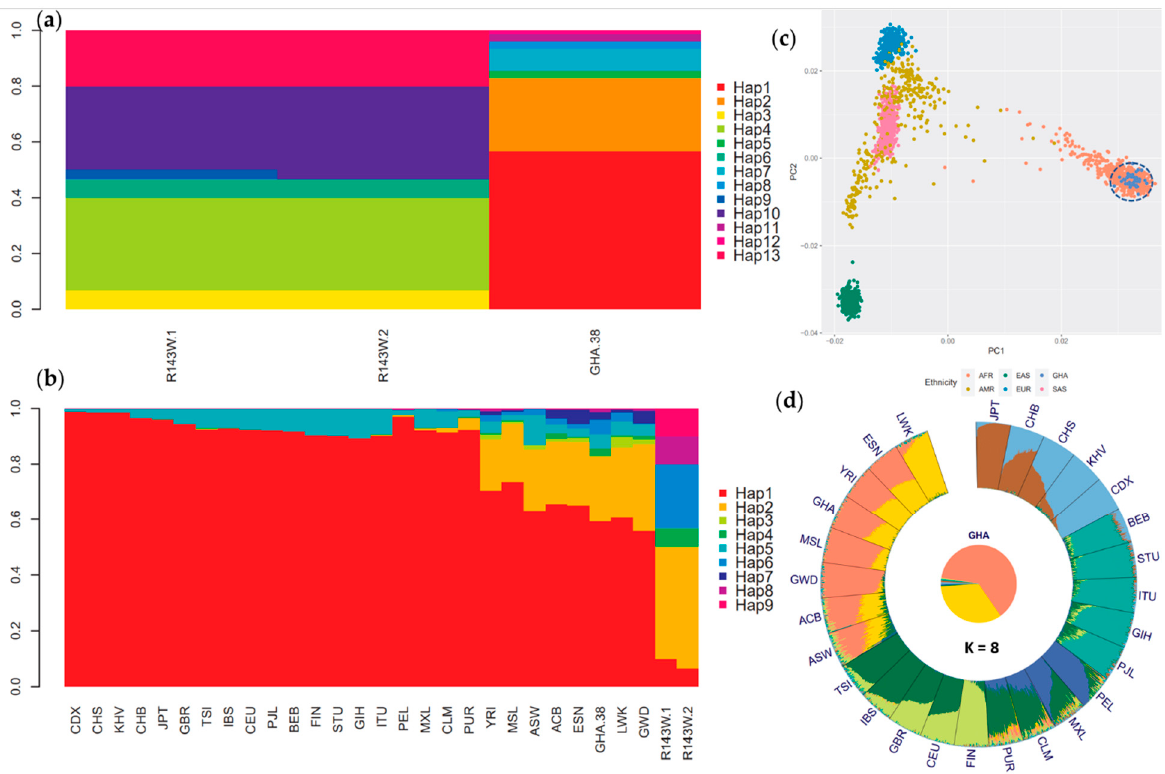
Figure 3. Haplotype frequencies in the R143W ‐ 1, R143W ‐ 2, GHA ‐ 38, and 1KGP3v5 populations and a global ancestry analysis. ( a ) Haplotype frequencies in Ghanaian samples R143W ‐ 1, R143W ‐ 2, and GHA ‐ 38 based on the 5 ‐ marker haplotypes. ( b ) Haplotype frequencies in Ghanaian (R143W ‐ 1, R143W ‐ 2, and GHA ‐ 38) and 1KGP3v5 populations based on the 9 ‐ marker haplotypes. ( c ) Principal Component Analysis showing the clustering of the continental populations. Ghanaian (GHA) pop ‐ ulation clustered with the African population as expected. EAS = East Asian Ancestry, AMR = Amer ‐ ican Ancestry, EUR = European Ancestry, and SAS = South Asian. ( d ) Bar plot of an unsupervised ADMIXTURE analysis of Ghanaian and the 1000 Genomes populations assuming 8 subpopulations (K). Luhya in Webuye, Kenya (LWK), Esan in Nigeria (ESN), Yoruba in Ibadan, Nigeria (YRI), R143W1 ‐ N Ghanaians (GHA), Mende in Sierra Leone (MSL), Gambian in Western Division—Man ‐ dinka (GWD), African Caribbean in Barbados (ACB), African Ancestry in SW USA (ASW), Toscani in Italia (TSI), Iberian Populations in Spain (IBS), Utah residents (CEPH) with Northern and Western